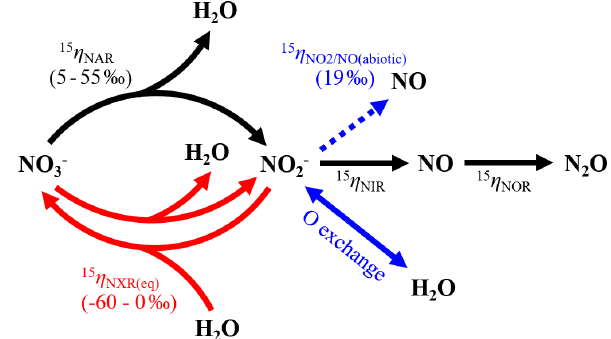
Figure 6. Model structure of co-occurring denitrification and NO − 2 re-oxidation and associated N isotope effects. Nitrogen transforma- tions driven by denitrifiers and nitrifiers are shown by solid black and red arrows, respectively, and abiotic O exchange between NO − 2 and H 2 O by the solid blue arrow. The dashed blue arrow denotes net NO yield from abiotic NO − 2